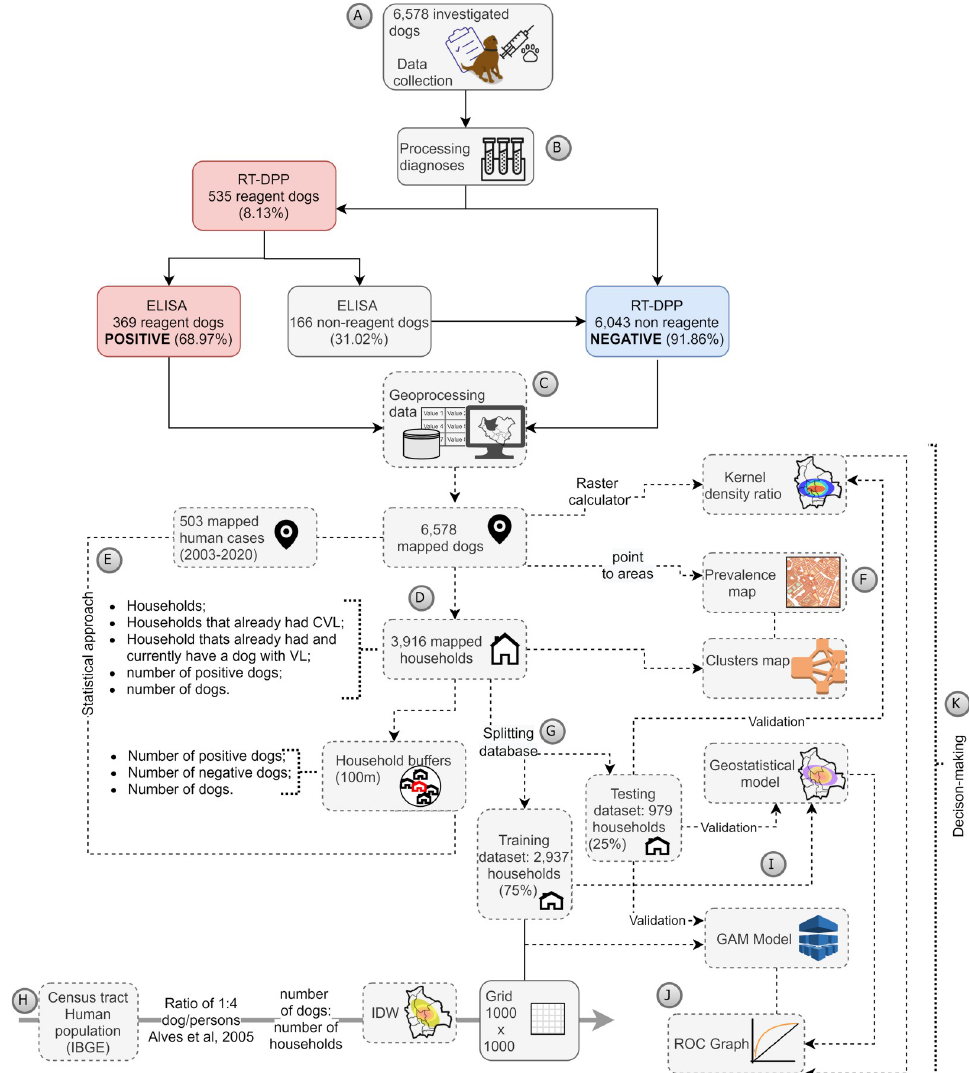
Fig 2. Synthesis of the performed methodology. The methodological proceedings were performed according to (a) Collecting samples and guardian’s survey. (b) Analyzing the samples. (c) Mapping the samples of dogs and human cases of VL. (d) Changing the scale of the dogs into households. (e) Applying statistical models. (f) Performing thematic maps. (g) Preparing data for the spatial model. (h) Preparing training data for the spatial model. (i) Validation of the models. (j) Using acquired knowledge for